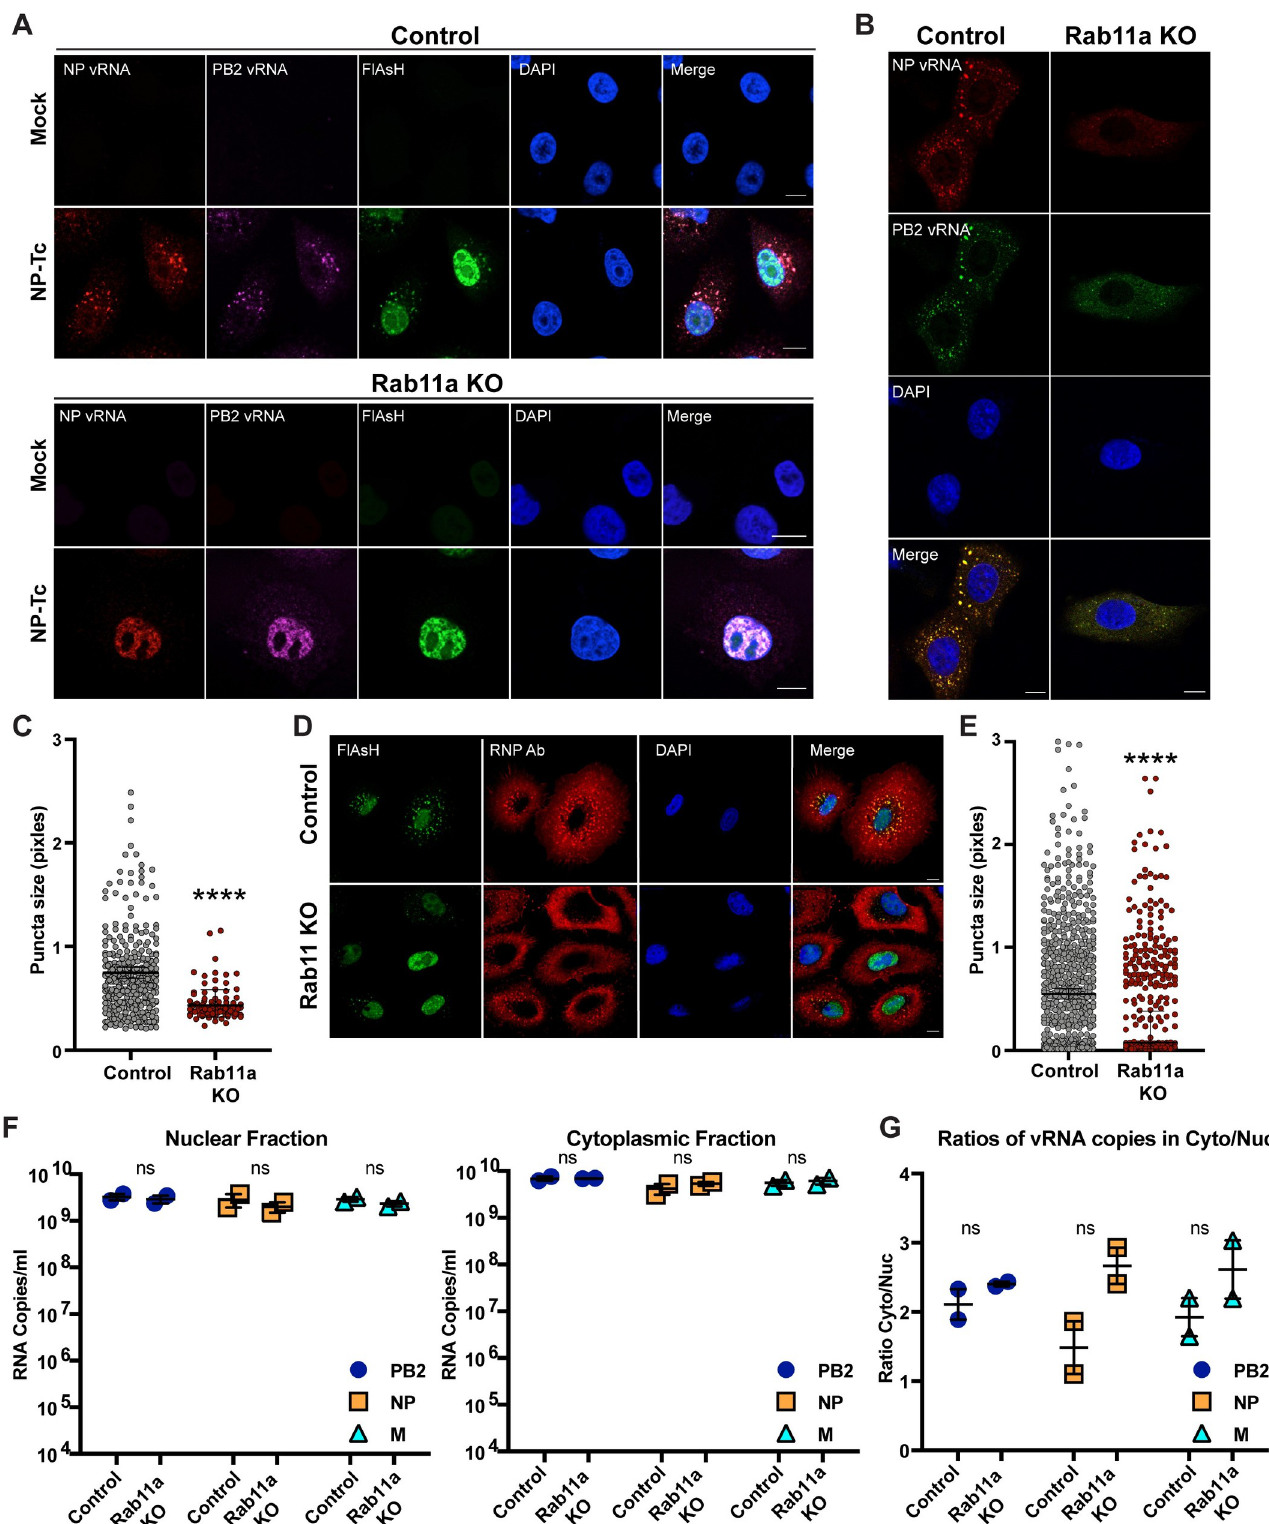
Fig 4. Absence of Rab11a affects IAV genome assembly. (A) vRNP complexes are scattered in the cytoplasm of Rab11a KO cells. Control A549 and Rab11a KO cells were infected with NP-Tc virus at MOI = 1 for 9 hours. Cells were stained with FlAsH dye to mark NP-Tc as well as with FISH probes against NP